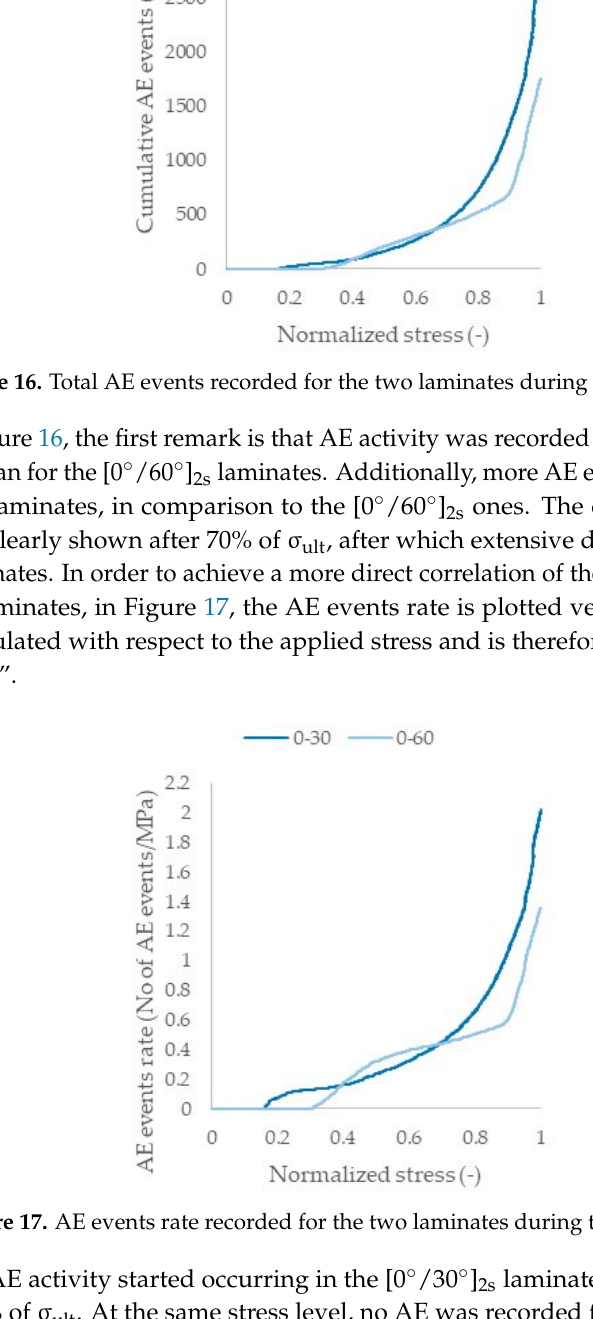
Figure 17. AE events rate recorded for the two laminates during the static tests.